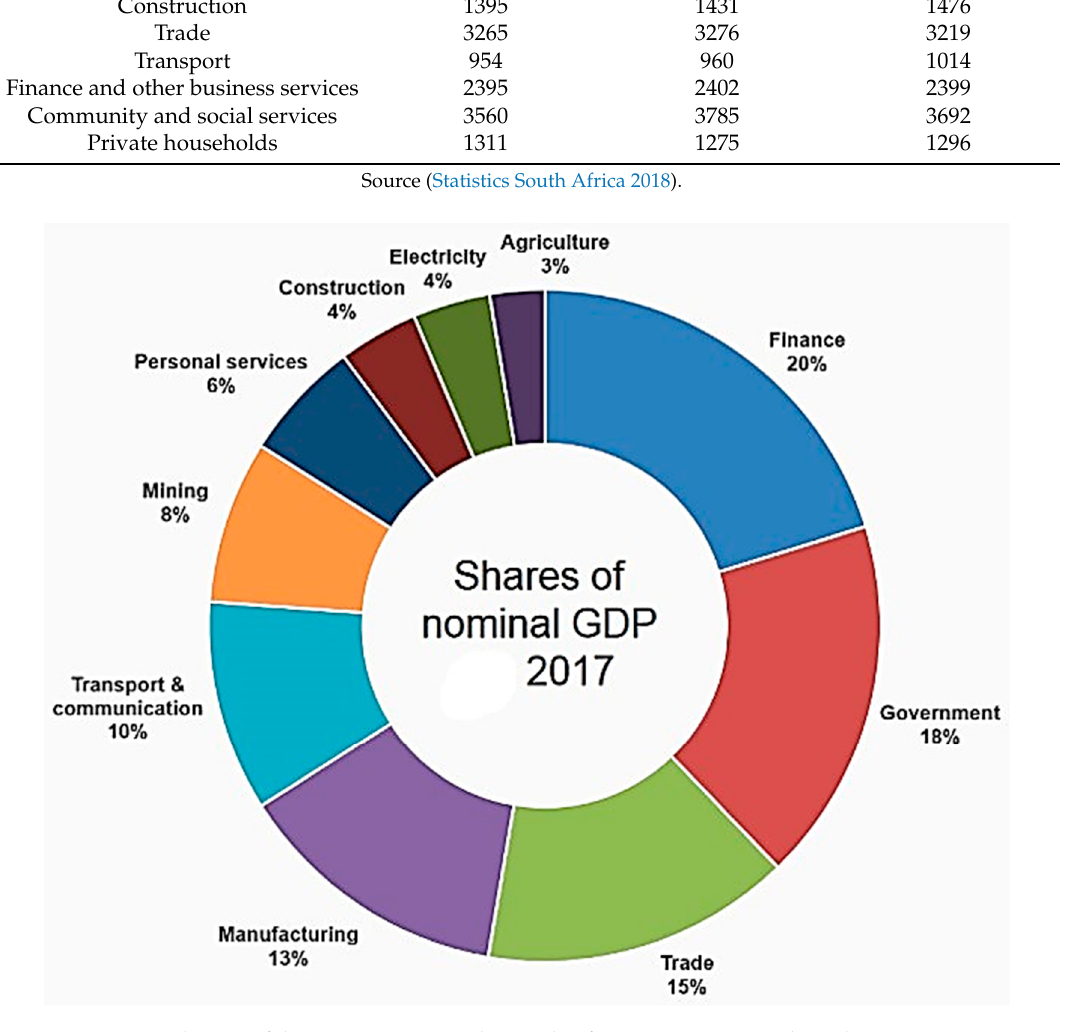
Figure 1. Contribution of the mining sector to the South African GDP compared to other sectors. Source (Brand South Africa 2018).